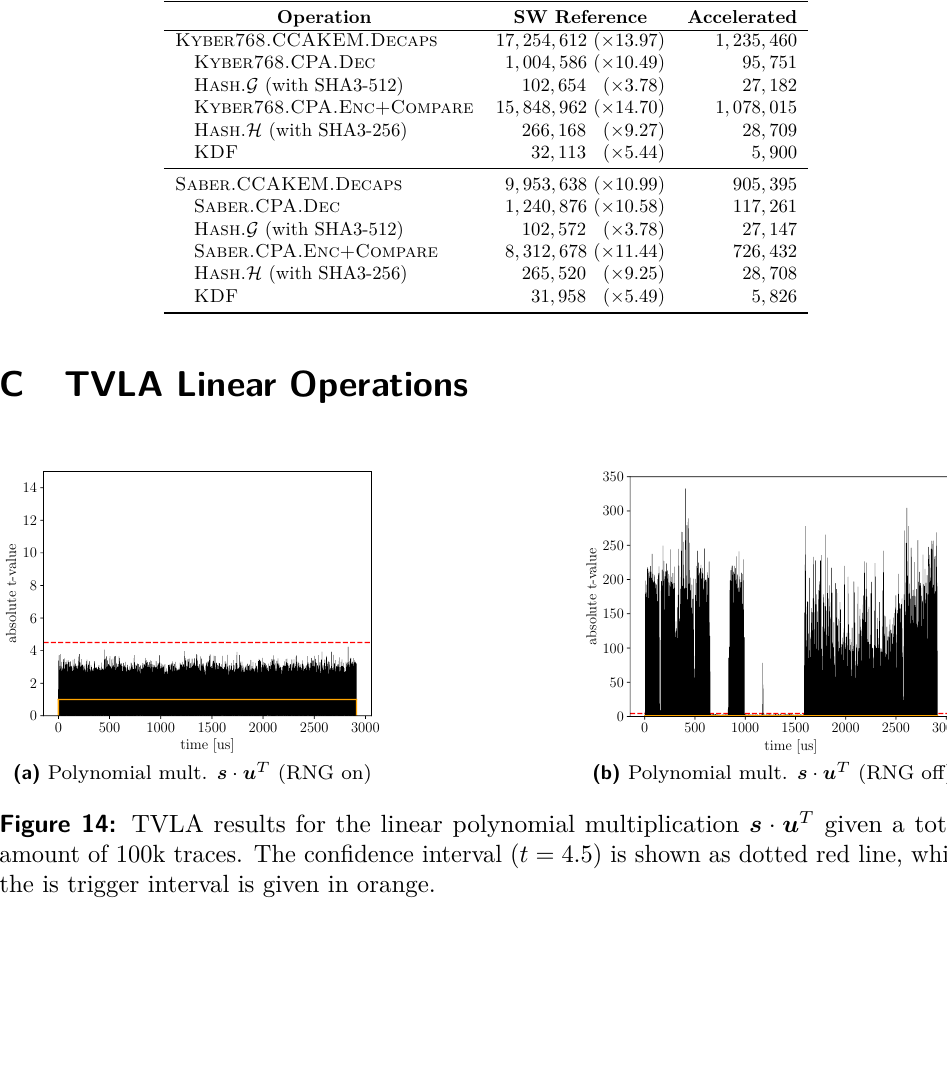
Table 10: Detailed cycle count masked CCAKEM.Decaps ( -O3 , GCC PULPino RISC-V compiler 7.1.1 20170509).